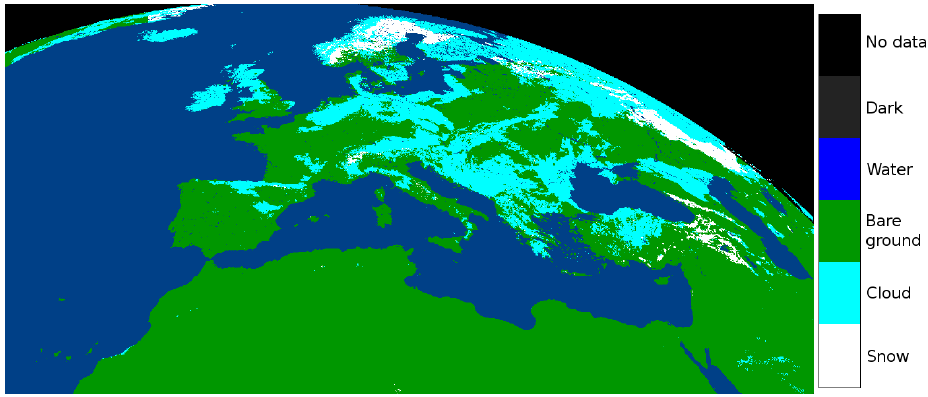
Figure 2. H-SAF H10 product (25° W–45° E, 25°–75° N), 5 April 2017.